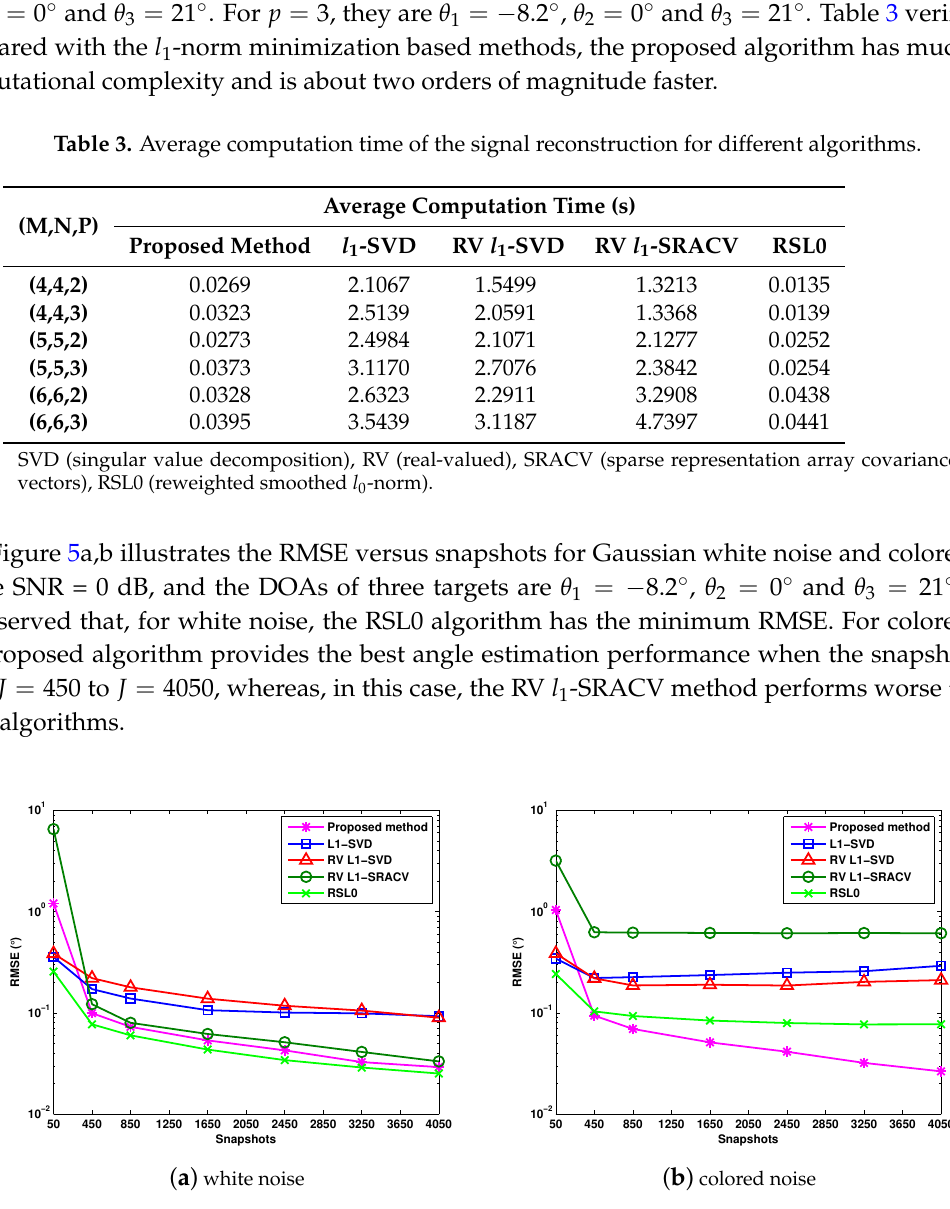
Figure 5. RMSE versus snapshots with SNR = 0